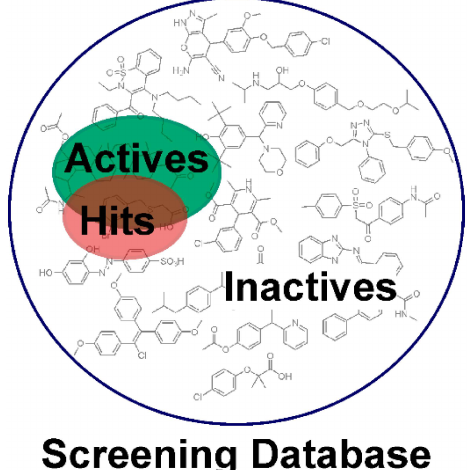
Figure 3. Enrichment of active molecules in the virtual hit list. Usually, the majority of compounds in a screening database are inactive molecules, while a small pool of bioactive molecules is contained. Pharmacophore-based virtual screening can help to enrich active molecules in the hit list compared to a random selection of test